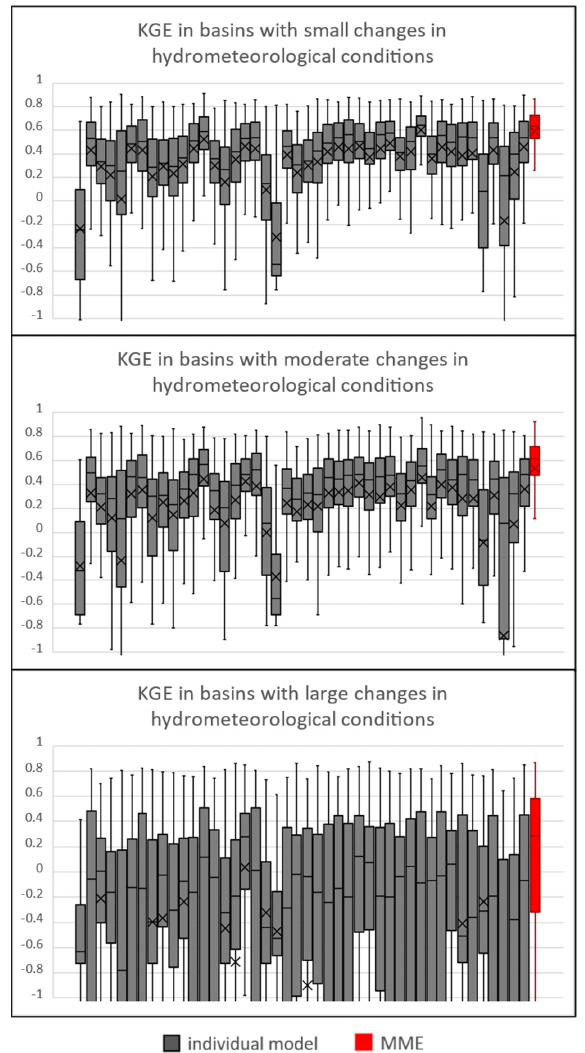
Figure 5. Box plots of KGE during the validation period in basins with small, moderate, and large changes in top 1% runoff. The absolute value of the change rate in the average of the top 1% runoff from the calibration period to the validation period was used as an indicator of changes in hydro- meteorological conditions. Basins with a value of less than 0.2 were considered to have small changes in hydrometeorological conditions, basins with a value between 0.2 and 0.4 were consid- ered to have moderate changes in hydrometeorological conditions, and basins with a value greater than 0.4 were considered to have large changes in hydrometeorological conditions (see Section 2.2). MME (red box) is based on the top 10 models of KGE in the calibration period.